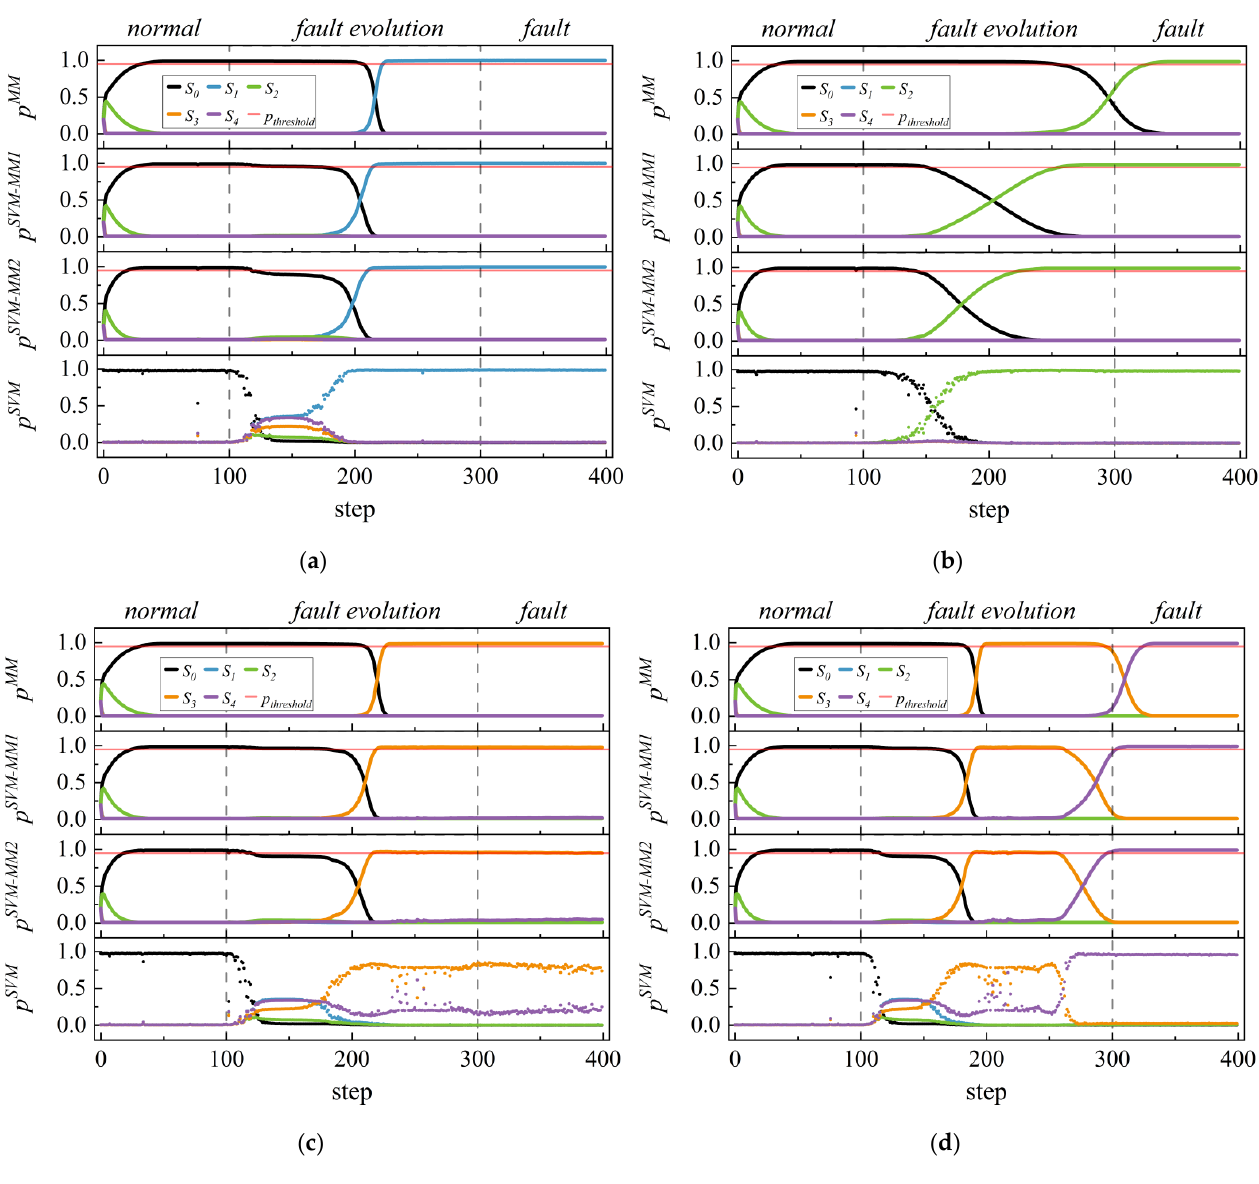
Figure 5. Probability calculated by four methods (MM, SVM, SVM-MM1, and SVM-MM2, α p in SVM-MM1 is 0.98, and α p in SVM-MM2 is 0.95) during fault diagnosis: ( a ) Fault S 1 diagnosis results; ( b ) Fault S 2 diagnosis results; ( c ) Fault S 3 diagnosis results; ( d ) Fault S 4 diagnosis